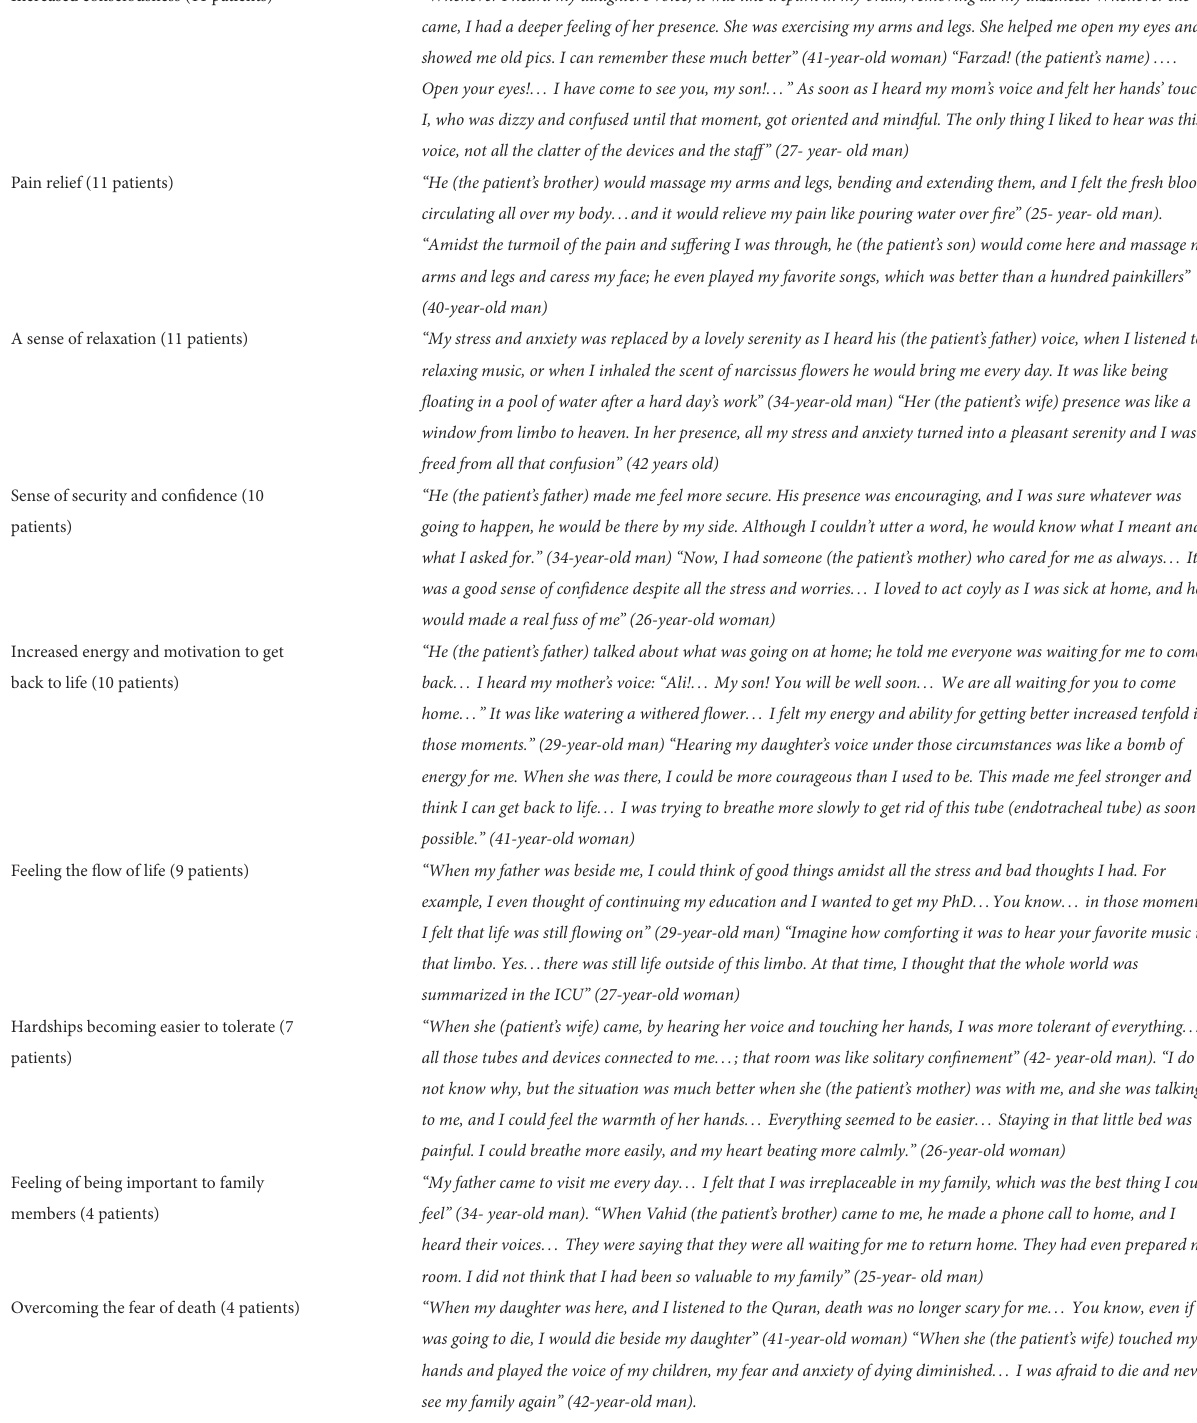
TABLE 5 Illustrative quotes (The presence of family: “A Window from Limbo to Heaven”).